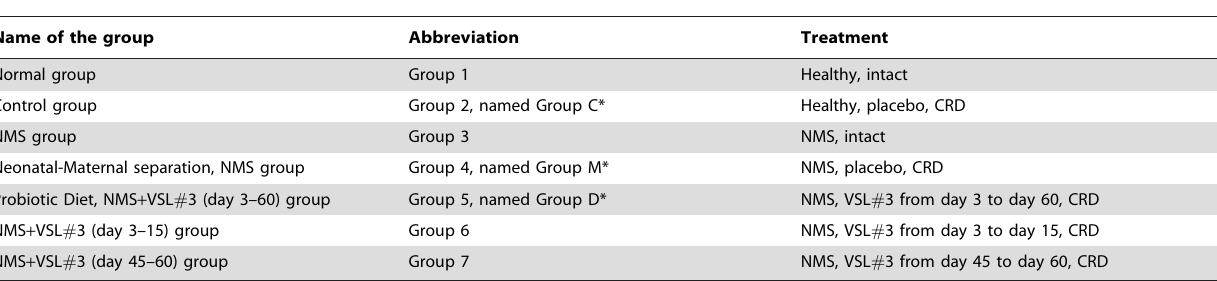
Table 1. Experimental design.